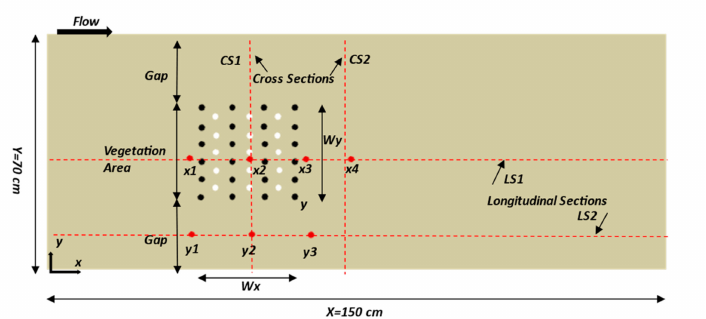
Figure 2. Top view of the vegetated channel setup and specified positions and sections. The red points depict the concerned locations, whereas the red dashed lines show the measurement